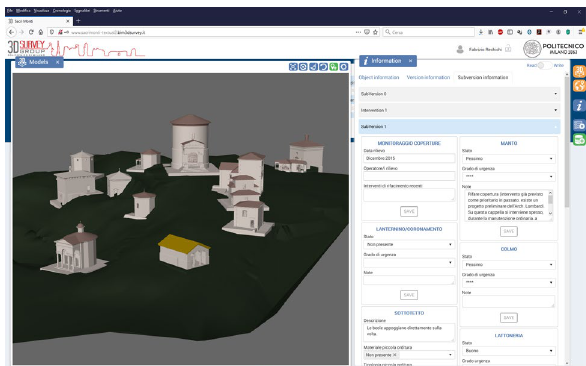
Figure 11 – Chimera working with Sacro Monte of Varallo; it is displayed the SubVersion information of a roof, that tracking the status of that roof through